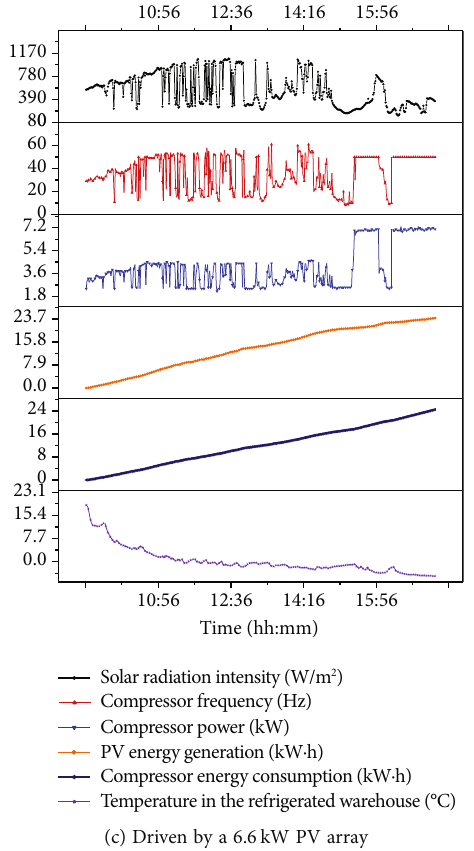
Figure 2: Changes in system operation performance parameters with di ff erent PV capacities. Table 3: The photoelectric performance characteristic of the system is driven by di ff erent PV capacities.